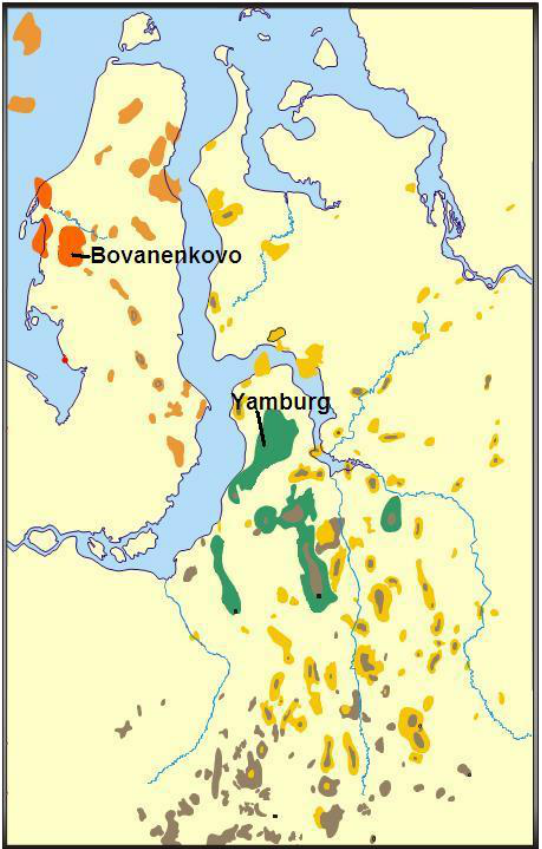
Figure 3. Locations of permafrost gas sampling around gas wells in West Siberia (Different colors indicate groups of gas fields).